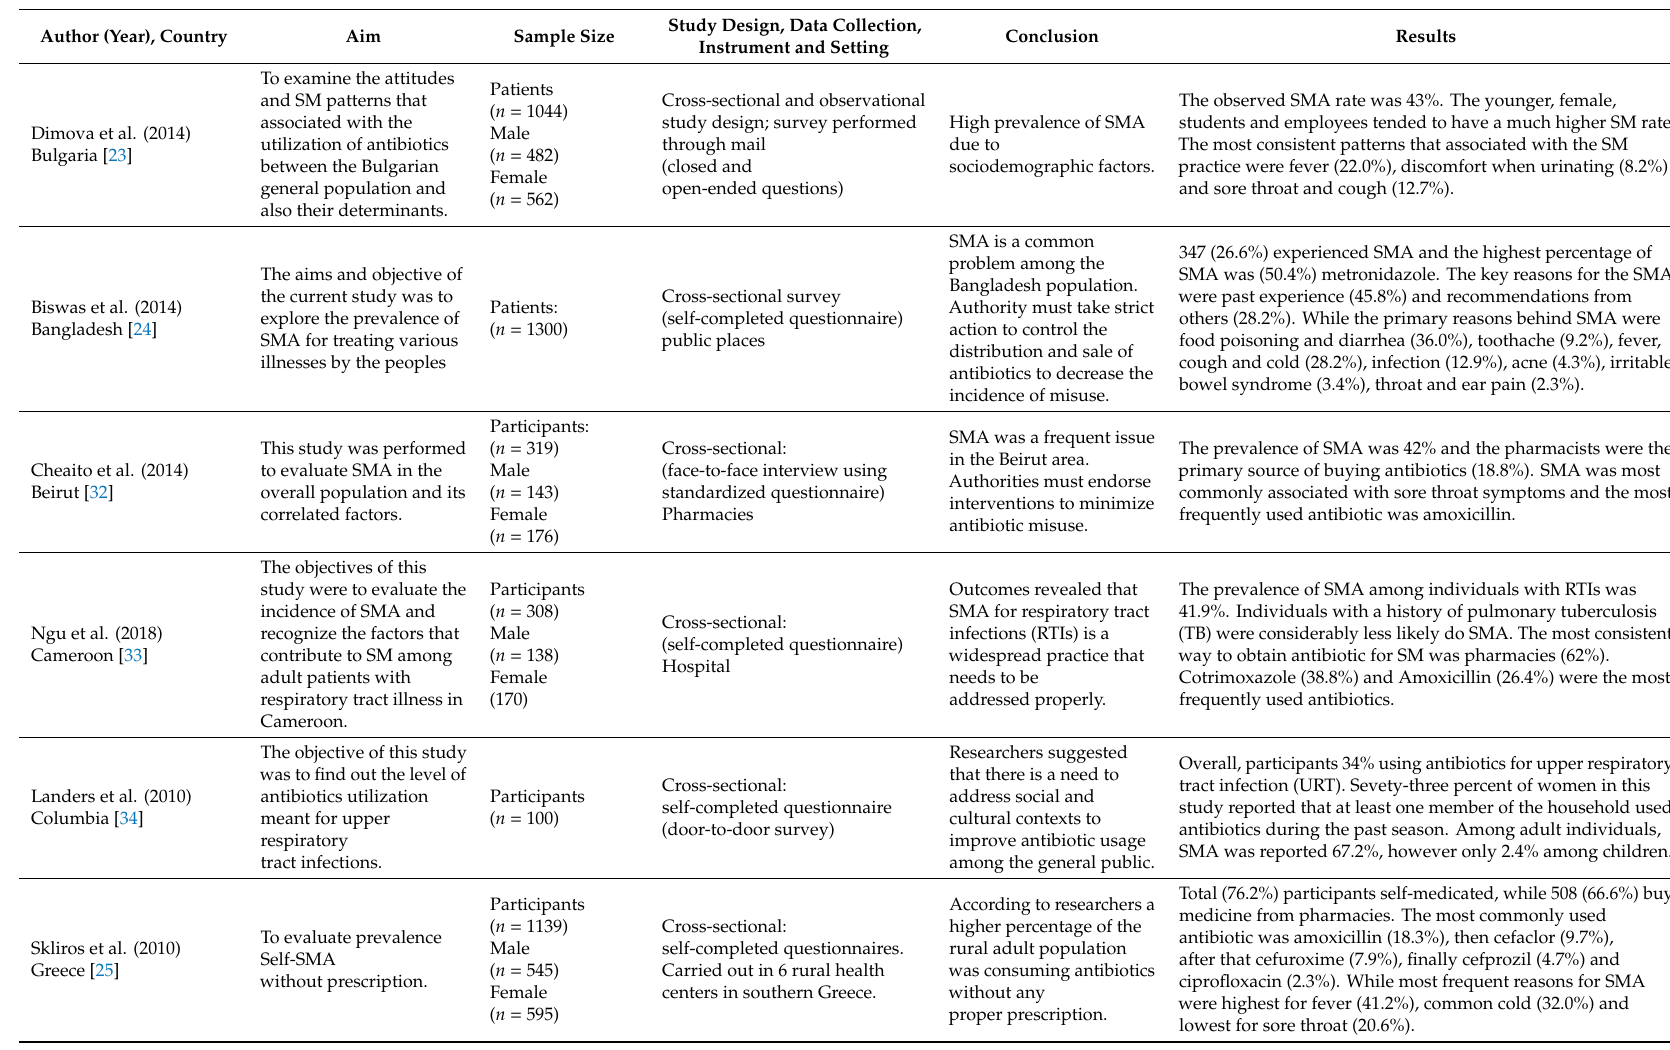
Table 1. Characteristics of included